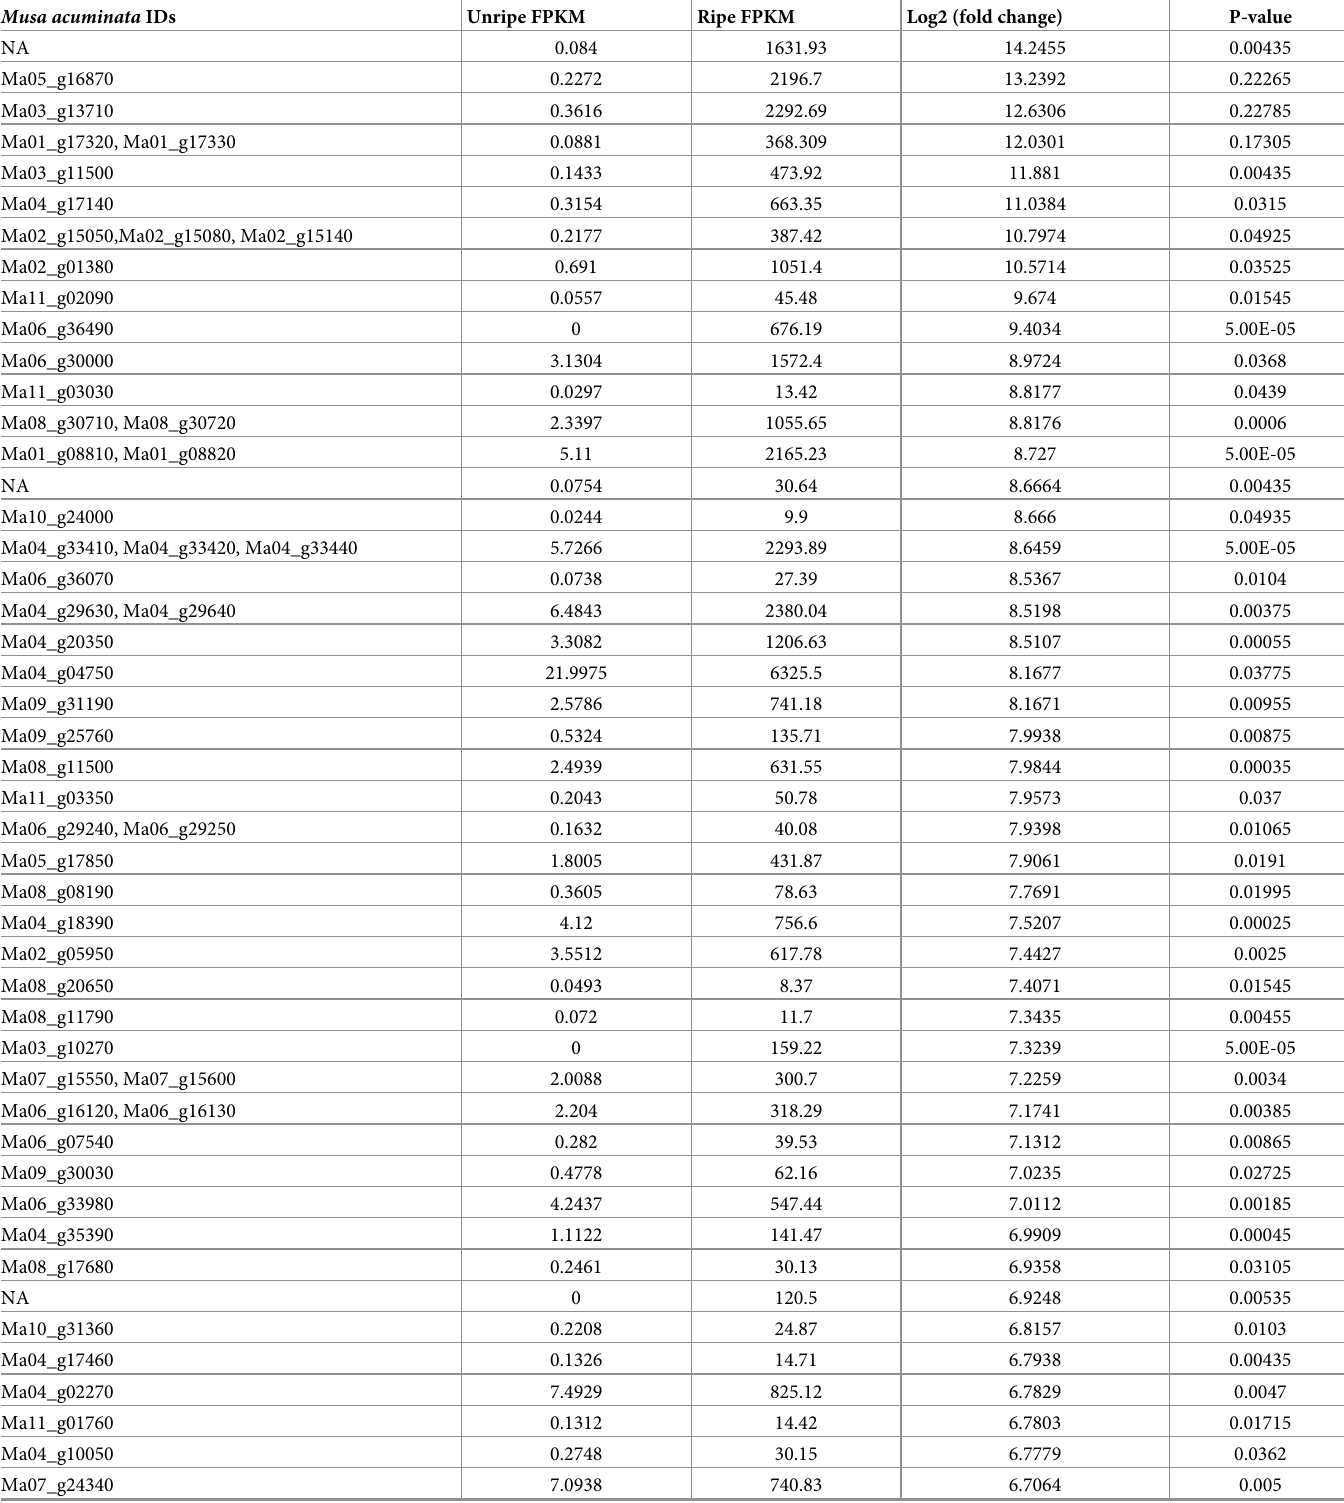
Table 2. List of top 50 up-regulated genes in Nendran ripe fruit samples. Musa acuminata